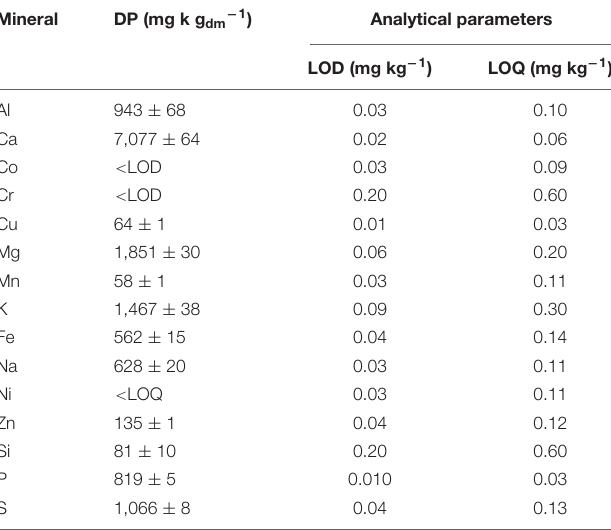
TABLE 2 | Main analytical parameters and mineral composition of DP by ICP-OES, expressed in mg per kg on dry matter basis ( n = 3, mean ± SD).